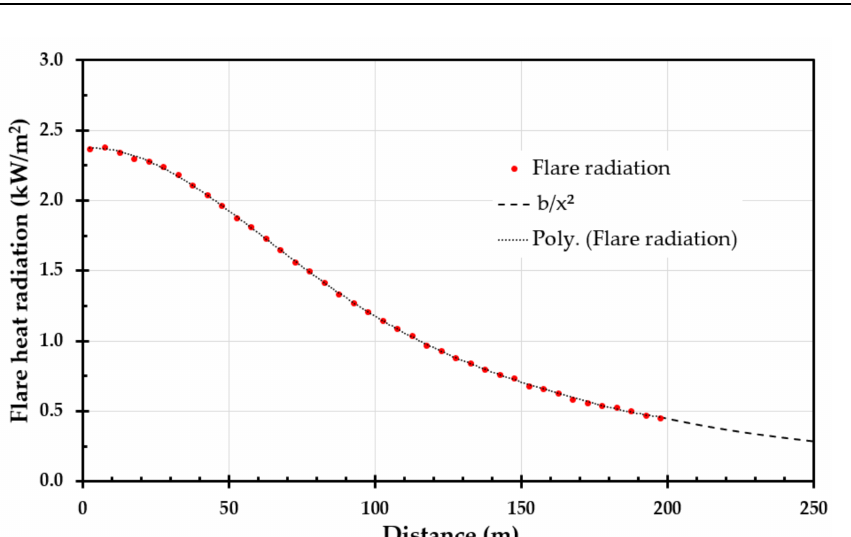
Figure 3. Net maximum flare heat radiation along the pavement for Case 1, Table